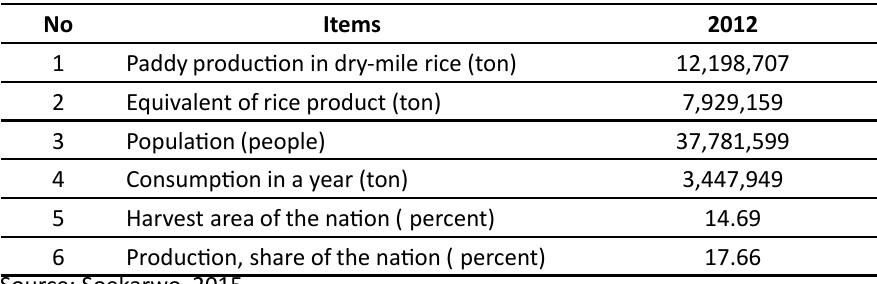
Table 1: Contribution of East Java to Rice Production in